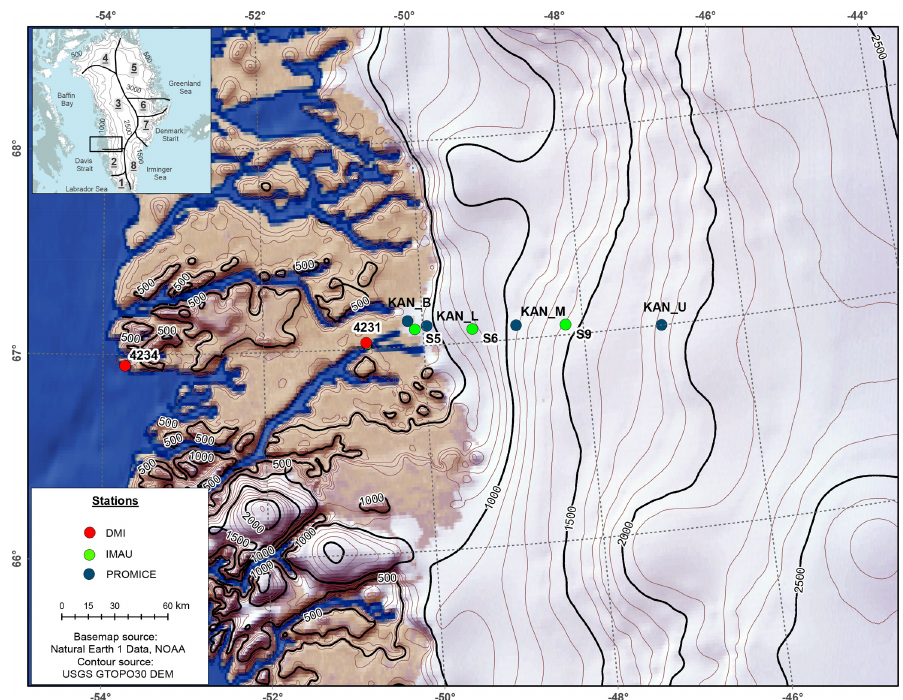
Figure 1. Study area map with PROMICE and IMAU K-transect sites and adjacent terrestrial DMI stations (Kangerlussuaq, WMO code 4231; and Sisimiut, WMO code 4234). The inset displays the northwest Atlantic Arctic region with superimposed GrIS topographically defined boundaries (adopted from Ohmura and Reeh,